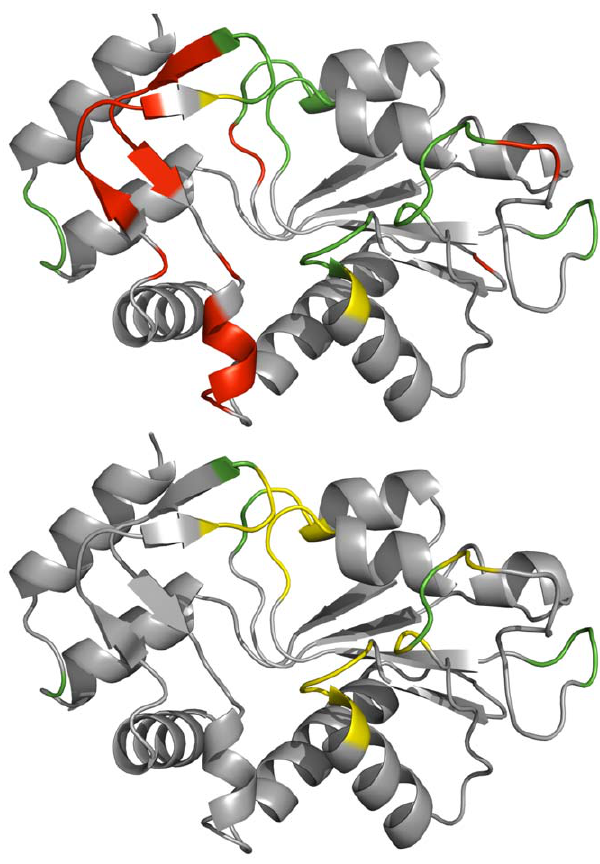
Figure 5. 1D projection of b -turn predictions for default and Q total optimized cut-off plotted on 3D structure 2WNS chain A. The figure shows the structure of a transferase, 2WNS chain A. The top structure shows a prediction where default cut-off has been used (NetTurnP) and the bottom structure shows the same structure where cut-off tweak has been applied (NetTurnP-tweak). Assigned b -turns are yellow, false positives are red, and the residues in green are where assignments and predictions agree. Figures were made using the PYMOL software [44].